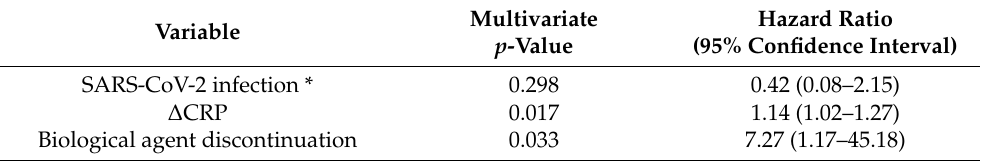
Table 4. Clinical characteristics of the 95 SARS-CoV-2-positive patients.